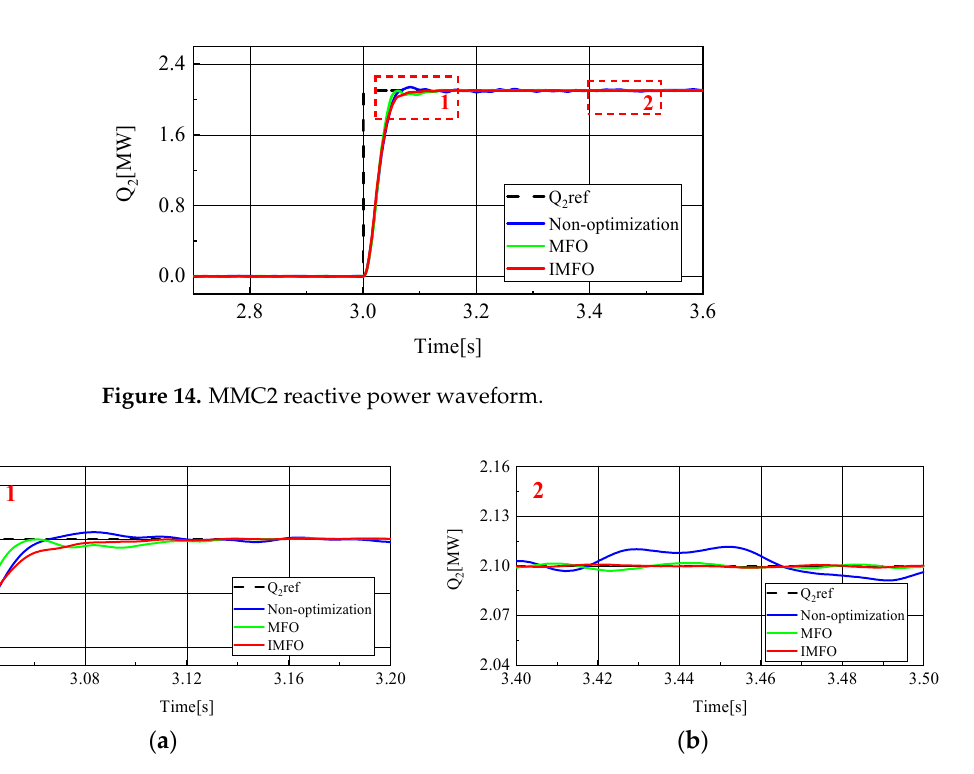
Figure 15. MMC2 reactive power local amplification waveform. ( a ) Locally amplified waveform 1. ( b ) Locally amplified waveform 2.